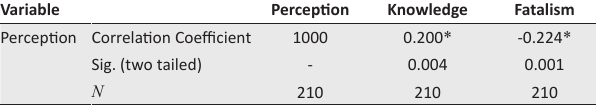
TABLE 4: Spearman correlation test